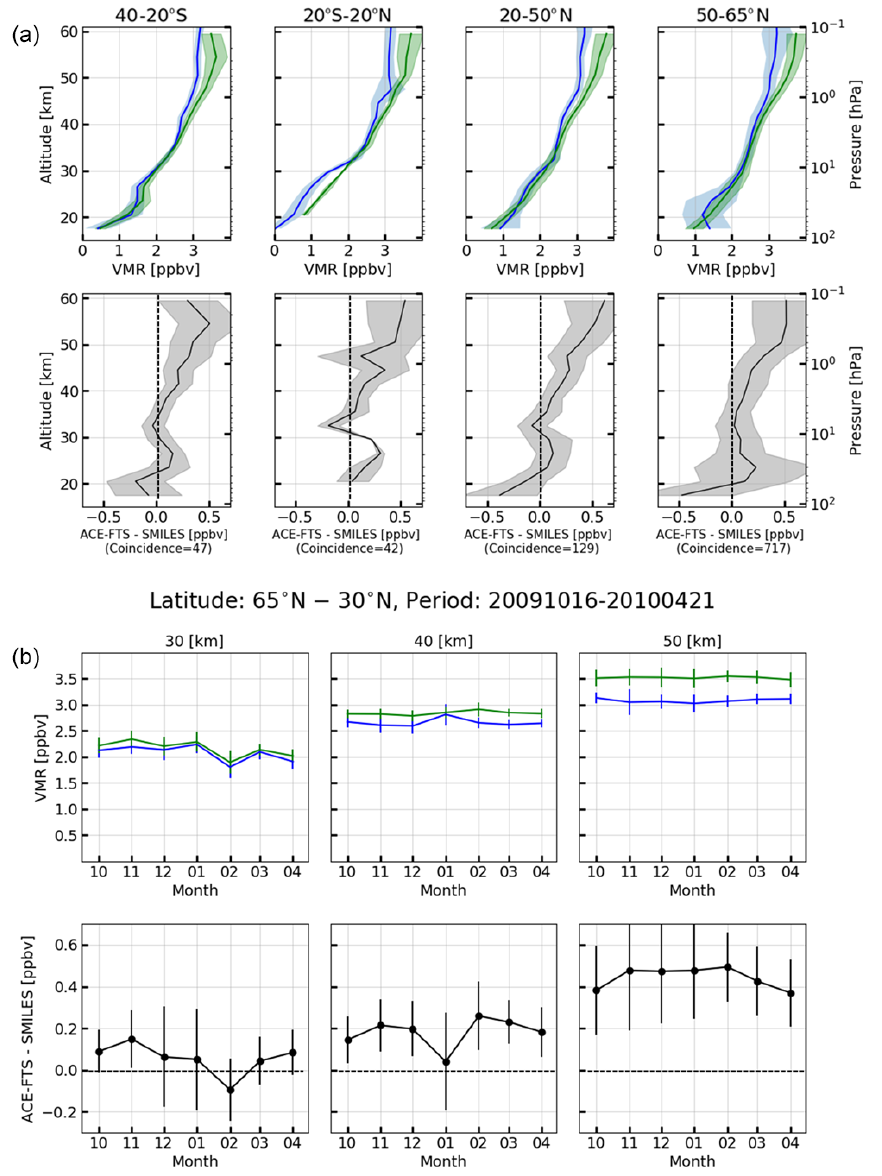
Figure 9. (a) The mean of HCl values, 1 σ , and the absolute difference for each latitudinal region are shown. Upper row: the blue and green lines indicate the SMILES HCl profiles and ACE-FTS profiles for each latitudinal region (40–20 ◦ S, 20–20 ◦ N, 20–50 ◦ N, and 50–65 ◦ N) from the left side. Lower row: the absolute difference between the SMILES and ACE-FTS profiles calculated using Eq. (3) for each latitudinal region. (b) Seasonal variation in the SMILES and ACE-FTS HCl profiles at three altitude levels. Latitudinal range is 30–65 ◦ N. Upper row: monthly mean of SMILES (blue) and ACE-FTS (green) HCl profiles for each altitude level. The error bars correspond to 1 σ . Lower row: the mean and 1 σ uncertainty of the absolute